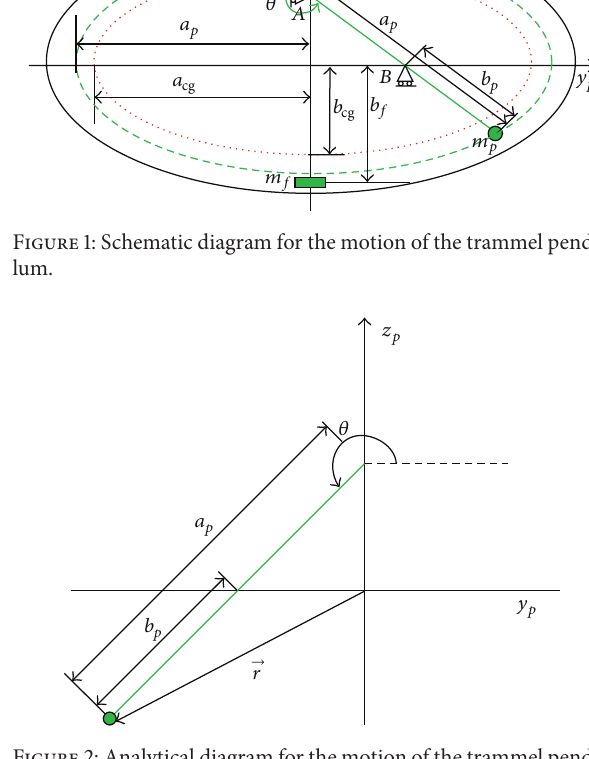
Figure 2: Analytical diagram for the motion of the trammel pendu- lum under an inertial coordinate